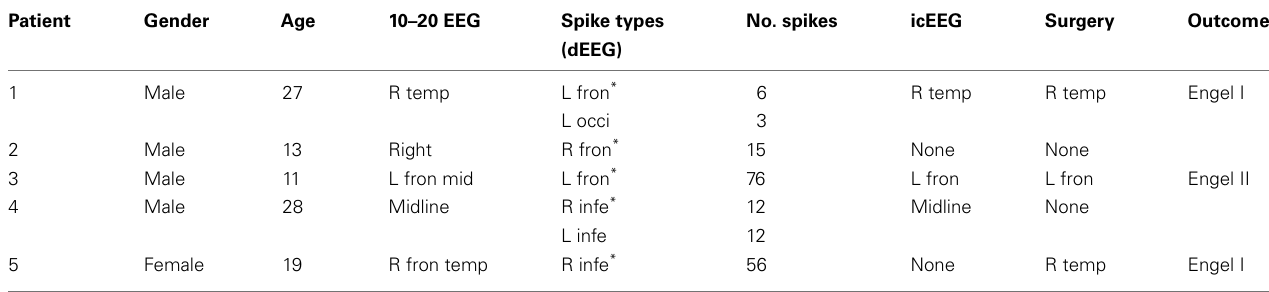
Table 1 | Clinical features of the 5